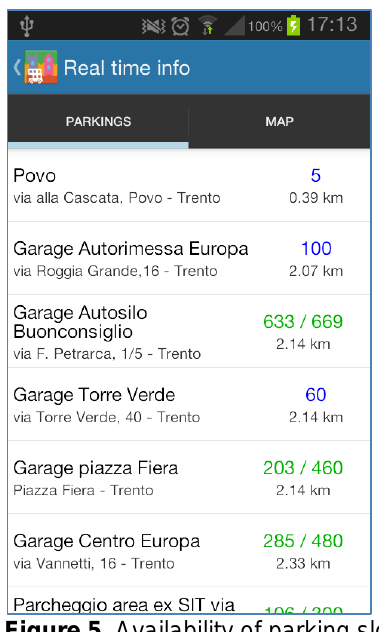
Figure 5. Availability of parking slots